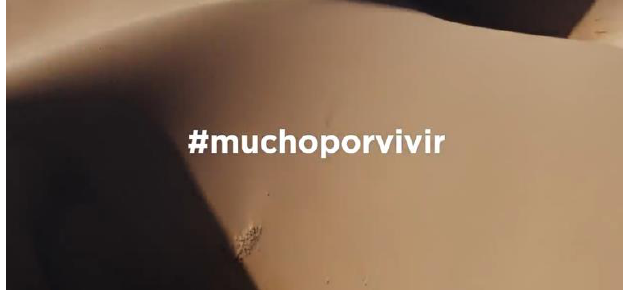
Figure 4. Capture of the campaign “ #Much to live ” .